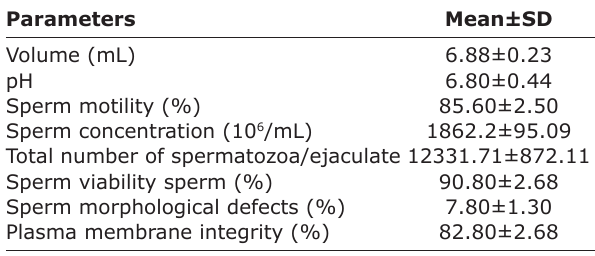
Table‑1: The Simmental bulls fresh semen quality (n=4 ejaculates).